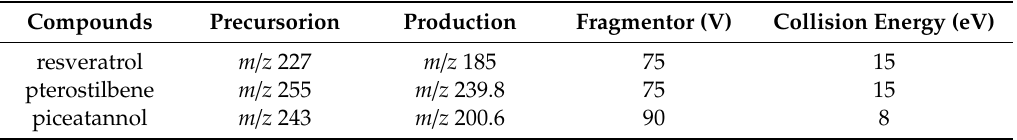
Table 1. The optimal parameters of target compounds in MRM